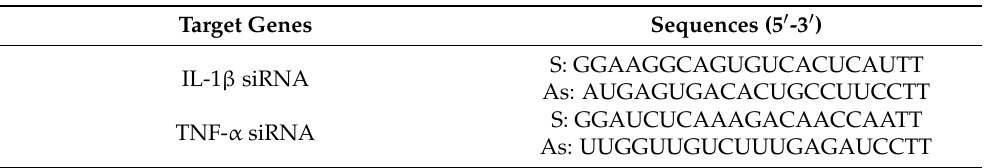
Table 1. siRNA sequences targeting IL-1 β /TNF- α